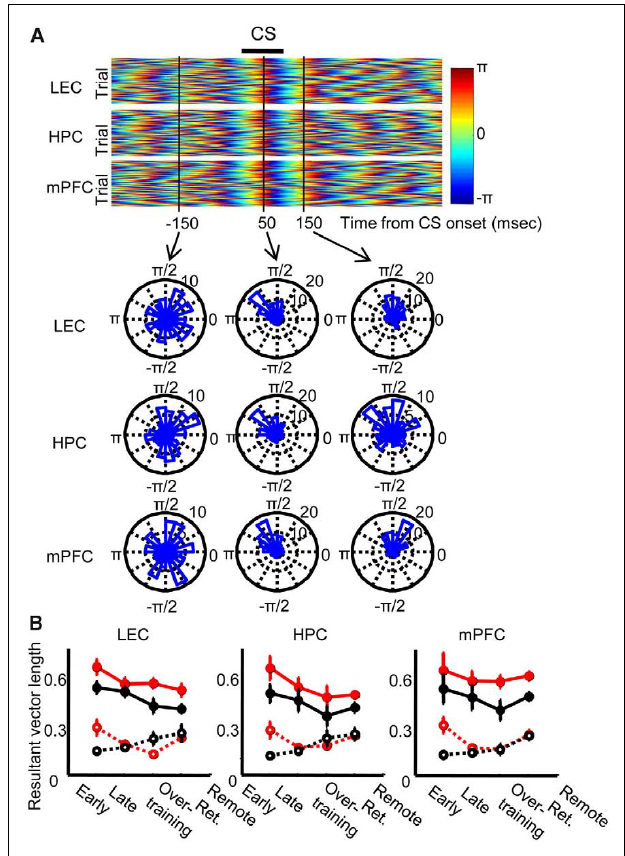
FIGURE 5 |Theta phase locking to the conditioned stimulus. (A) A representative pseudo-color scale representation of instantaneous theta phase in each trial, which was aligned at CS onset.Theta oscillations in the lateral entorhinal cortex (LEC, top), dorsal hippocampus (HPC, middle), and medial prefrontal cortex (mPFC, bottom) were locked to the CS and subsequently entrained for about two oscillation cycles. Phase distribution across trials was random at 150ms before CS onset (left), but it was strongly concentrated at 50 and 150ms after CS onset (middle and right). (B) Degree of phase concentration was quantified by using the length of resultant vector for instantaneous phase across trials during which rats showed CRs (CR trials, red, mean ± SEM) or trials during which no CR was expressed (non-CR trials, black, mean ± SEM). In both CR and non-CR trials, phase entrainment became stronger after CS onset (solid line) than before CS onset (dotted line) in all stages (Early, the first-third acquisition session, six rats; Late, the forth to seventh acquisition session, six rats; Overtraining, the eighth to tenth acquisition session, six rats; Remote Ret., five retention sessions 1month later, eight rats) in all three